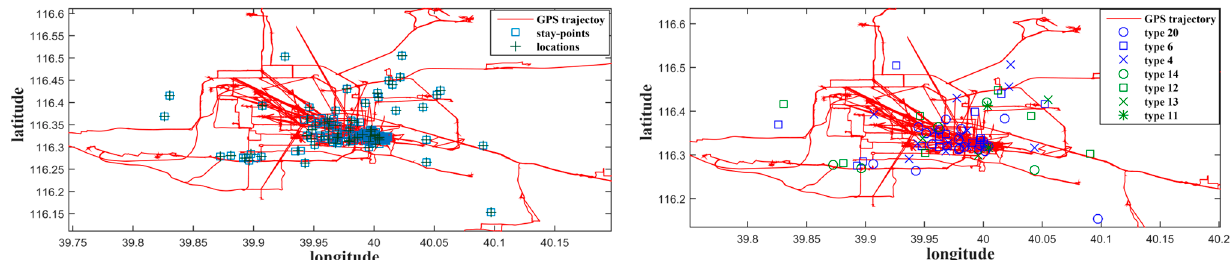
Figure 4. Stay-points and semantic tagging.